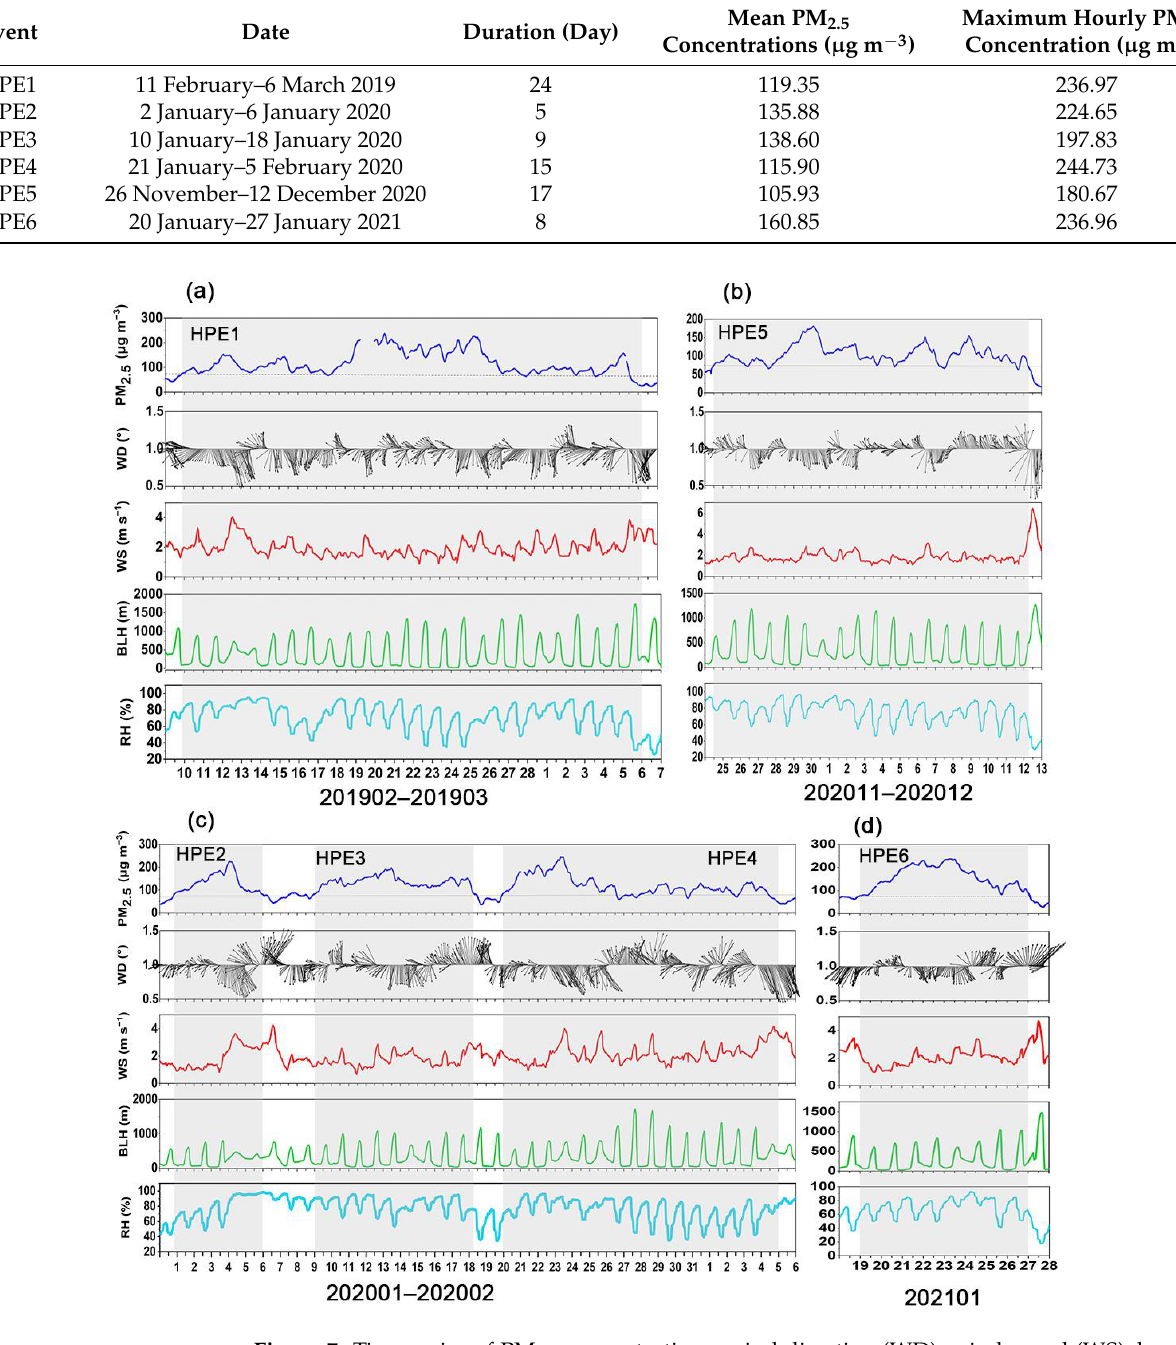
Figure 7. Time series of PM 2.5 concentrations, wind direction (WD), wind speed (WS), boundary layer height (BLH), and relative humidity (RH) during six heavy PM 2.5 pollution episodes (HPEs) in Henan. ( a ) HPE1, ( b ) HPE5, ( c ) HPE2, HPE3, and HPE4, and ( d ) HPE6.